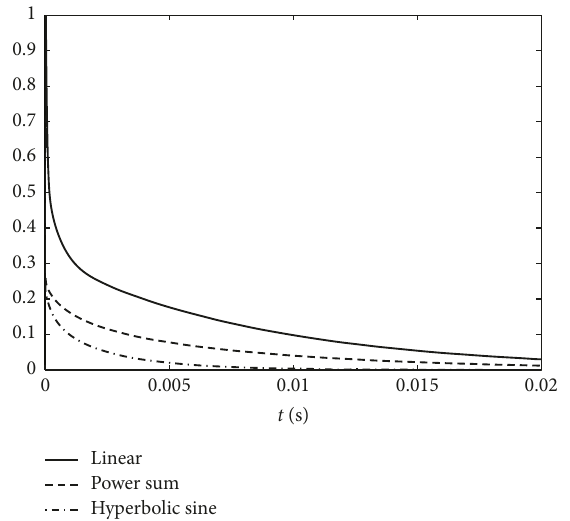
Figure 2: Solution error ‖𝑋(𝑡)−𝑋 ∗ ‖ 𝐹 synthesized by (2) for GLME (24) with the unique theoretical solution 𝑋 ∗ , starting from the same randomly generated initial state 𝑋(0) ∈ 𝑅 2×2